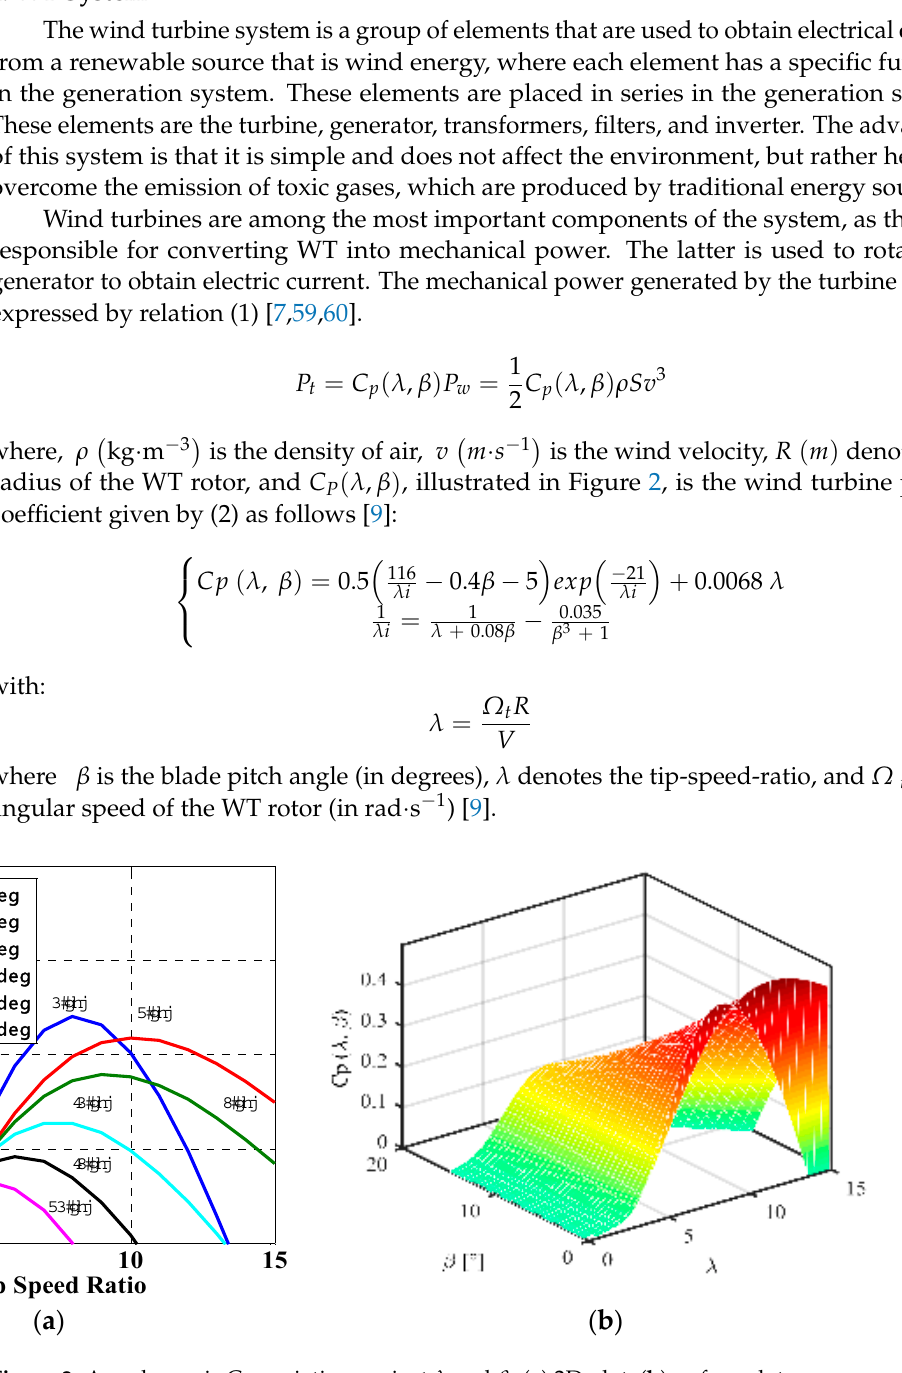
Figure 2. Aerodynamic Cp variation against 𝜆 and β . ( a ) 2D plot, ( b )surface plot.